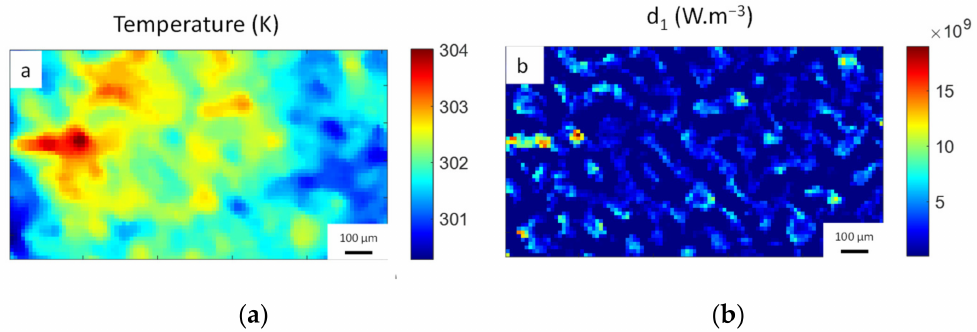
Figure 5. ( a ) Temperature field graph; ( b ) intrinsic dissipation graph at 7.193 × 10 7